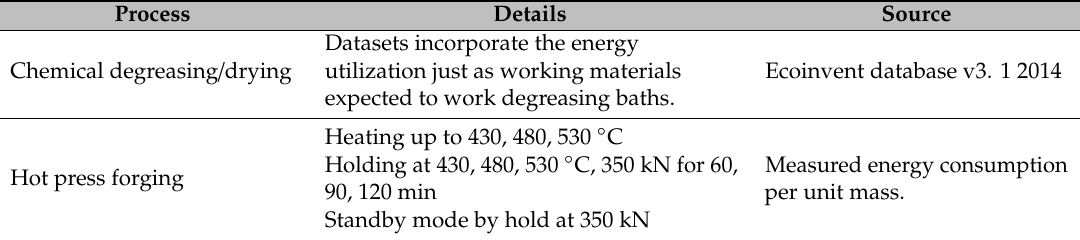
Table 2. Main inventories data and sources for each process and materials.